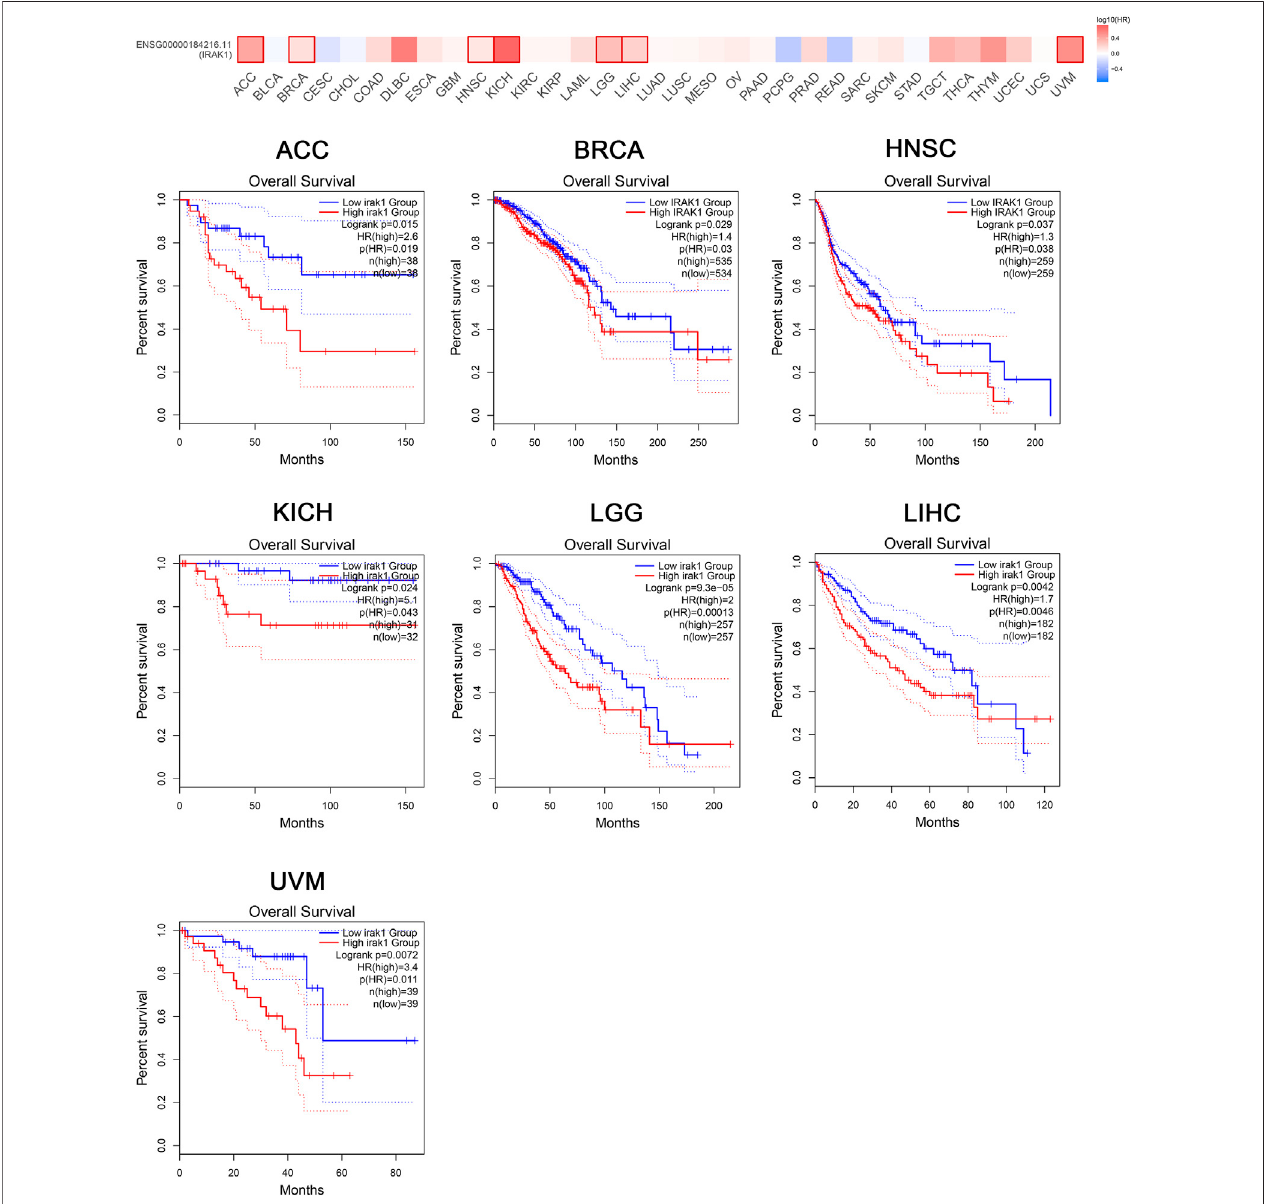
FIGURE 2 | Kaplan-Meier overall survival curve of pan-cancers with high and low expression of IRAK1. Correlations between IRAK1 gene expression and overall survival from TCGA database are showed. The GEPIA2 tool was used to show the survival map and perform the survival curves.